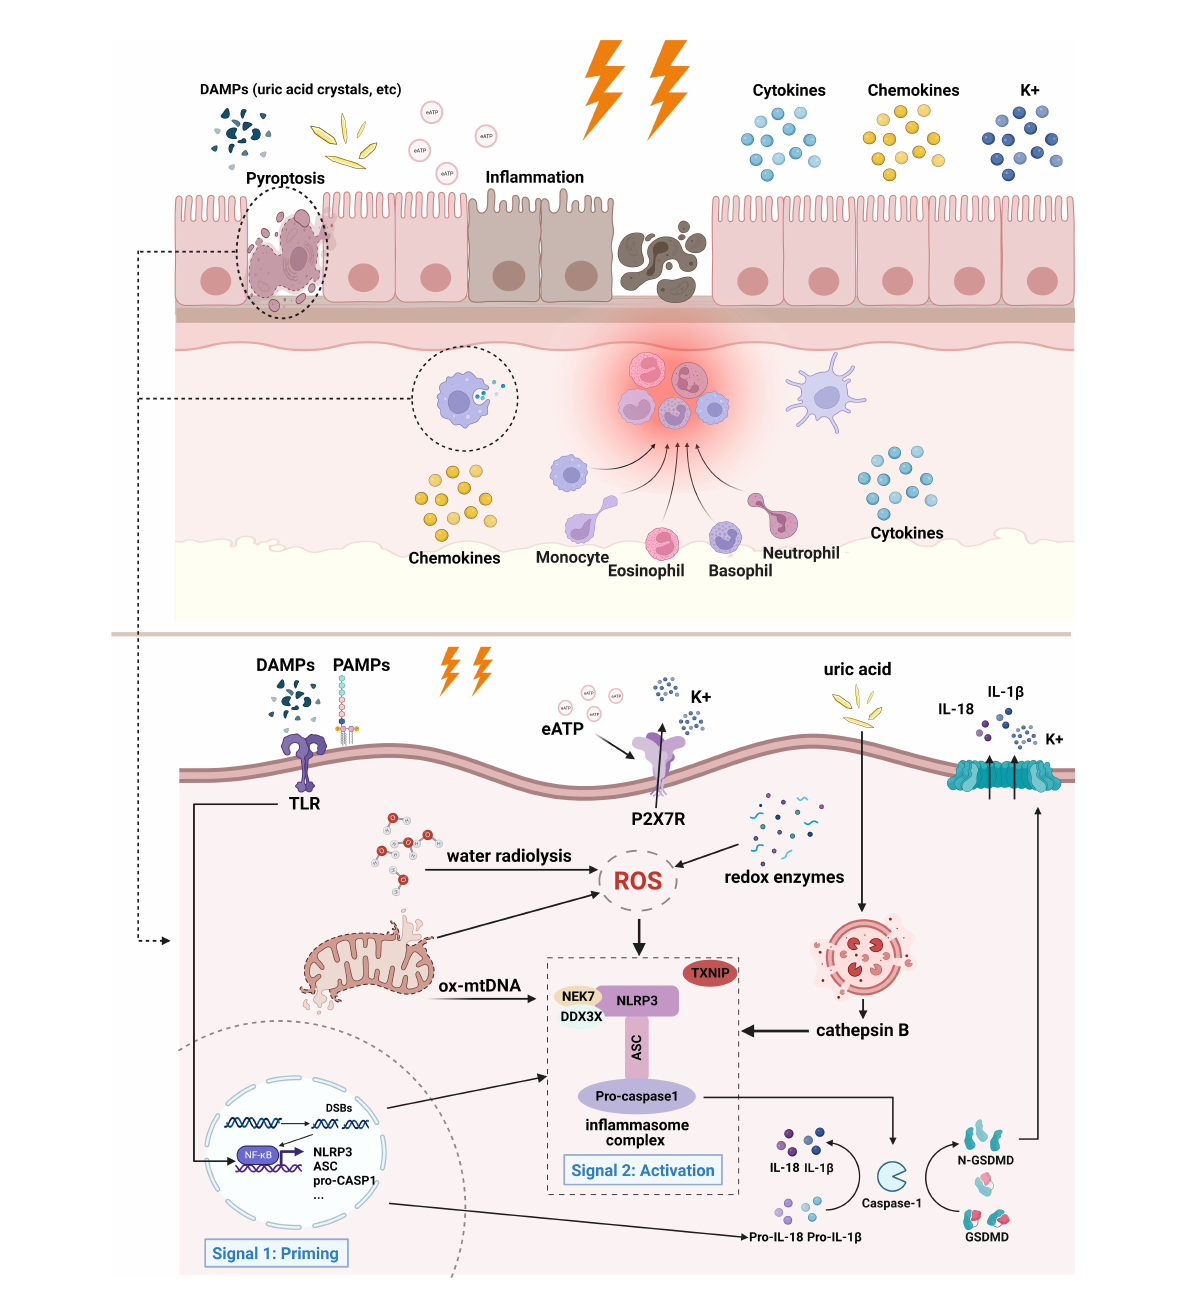
FIGURE 1 Mechanism of radiation-induced NLRP3 in fl ammasome activation. In the case of intestinal epithelial cells and in fi ltrating macrophages, irradiated cells initiate in fl ammatory responses and eventually undergo cell death. Adjacent cells may also be affected by in fl ammation. Speci fi cally, extracellular PAMPs and DAMPs act as priming signals, binding to and inducing TLR signaling, thereby promoting the activation of NF- k B and the transcription of in fl ammasome components and pro-IL-1 b . The activation signals entail ROS, K + ef fl ux, release of mitochondrial DNA, lysosomal rupture and cathepsin release, etc. ROS is produced from the radiolysis of water, redox enzymes, and dysfunctional mitochondria. Lysosomal membrane may be destabilized by particulate or crystalline structures (like uric acid crystal) and then lead to lysosomal rupture, releasing cathepsin B. Mitochondrial dysfunction gives rise to the release of mtDNA and cardiolipin. These activation signals stimulate NLRP3 in fl ammasome and lead to its oligomerization. Activated NLRP3 in fl ammasome mediates the maturation of IL-1 b and IL-18, as well as induces pyroptosis by cleaving GSDMD. The downstream effects of NLRP3 in fl ammasome activation are characterized by the production of cytokines, chemokines, and recruitment of immune cells, followed by cell death. Of notes, the contribution of mtDNA and extracellular ATP to radiation- induced in fl ammasome has not yet been con fi rmed, therefore they are illustrated with fading